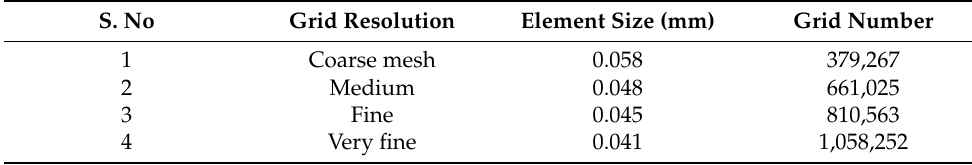
Figure 4. Grid for the fluid domain of MCHS. Table 3. Grid number for different element